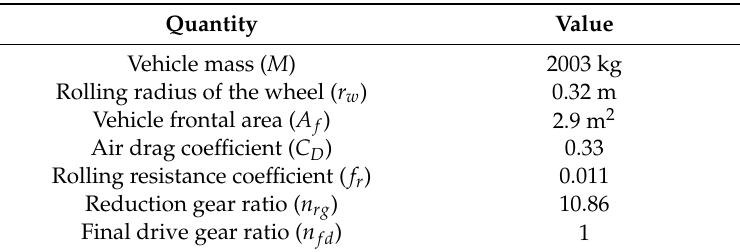
Figure 2. Configuration of the REEV. Table 1. REEV specifications.